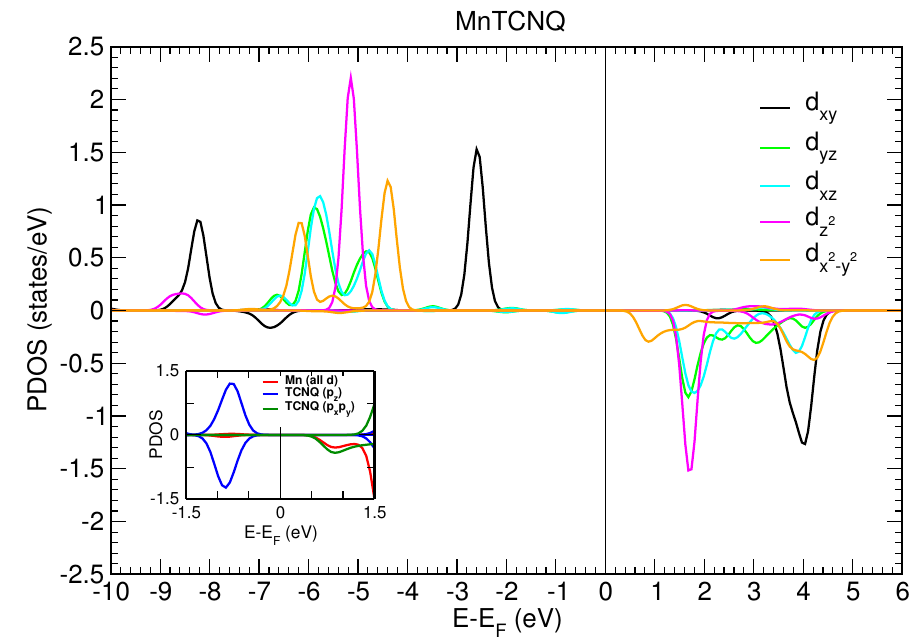
Figure 6. Projected density of states (PDOS) onto the five different Mn(3d) orbitals for Mn–TCNQ. The inset shows the PDOS onto p orbitals of C and N atoms in TCNQ, as well as onto all Mn(3d) orbitals, in a narrow energy range close to the Fermi level ( E F ). Note that the p z contributions of C and N atoms account for the lowest unoccupied molecular orbital (LUMO).